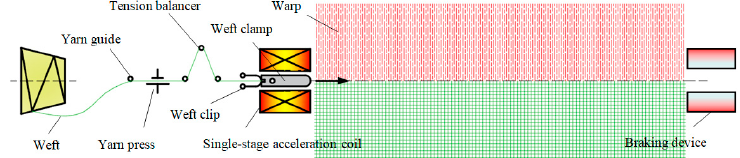
Figure 1. Schematic diagram of single-stage electromagnetic weft